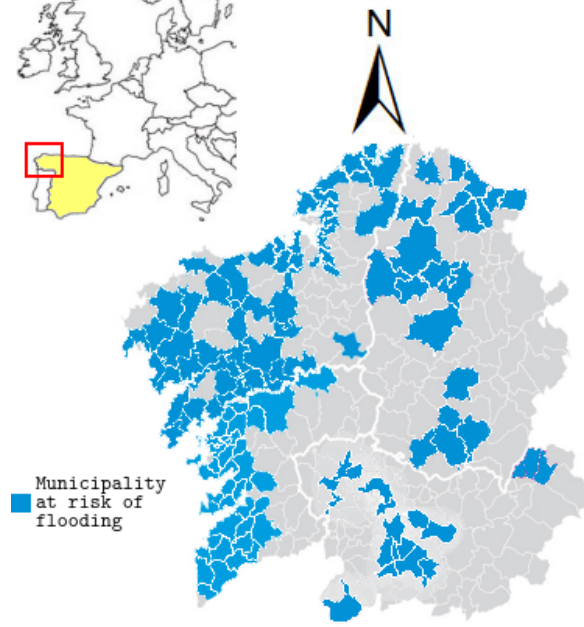
Figure 2. Municipalities of Galicia that are at regular risk of flooding. Sources: the regional government (Xunta de Galicia) and Miño–Sil river authority Confederación Hidrográfica Miño–Sil.